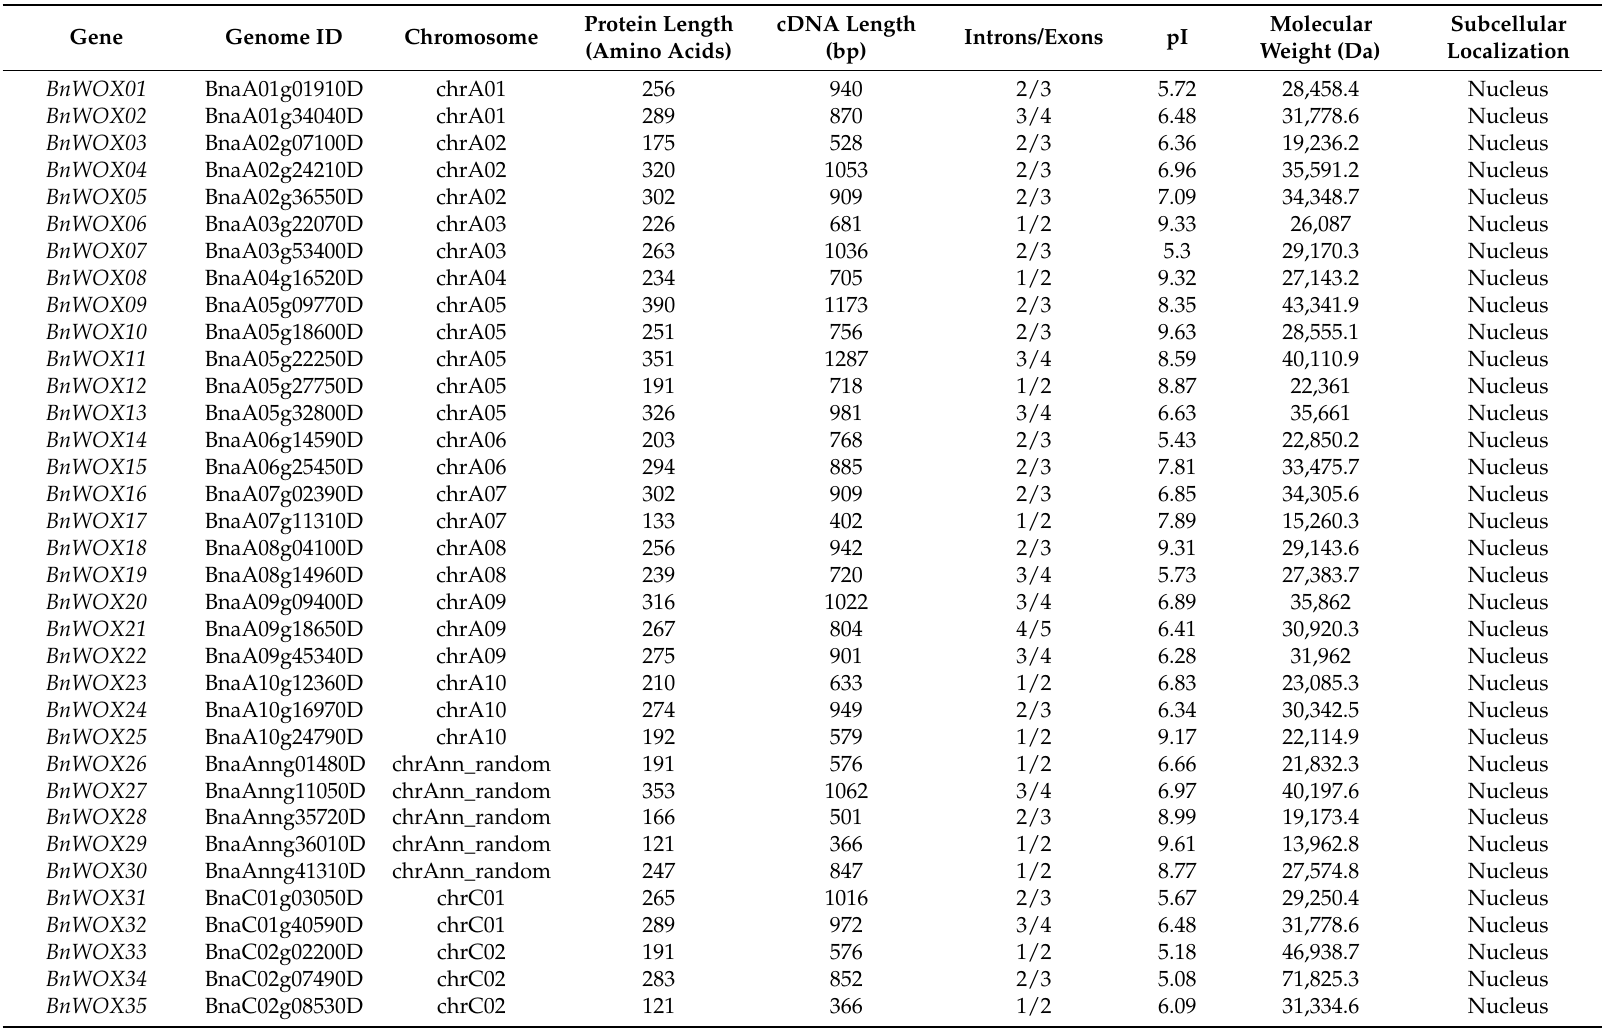
Table 1. Features of the 58 BnWOX genes from Brassica napus , identified in this